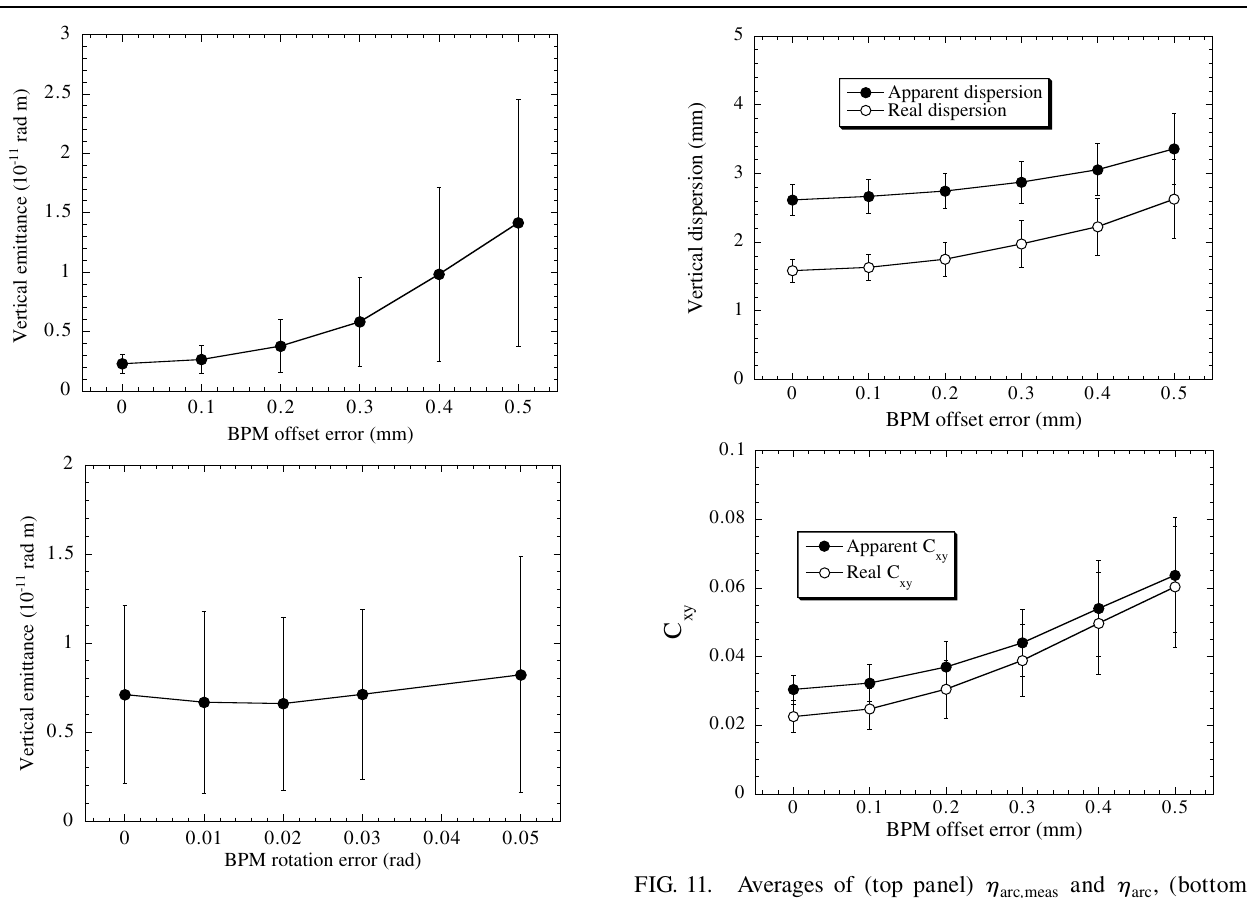
vs (top panel) BPM offset error ( (cid:27) y